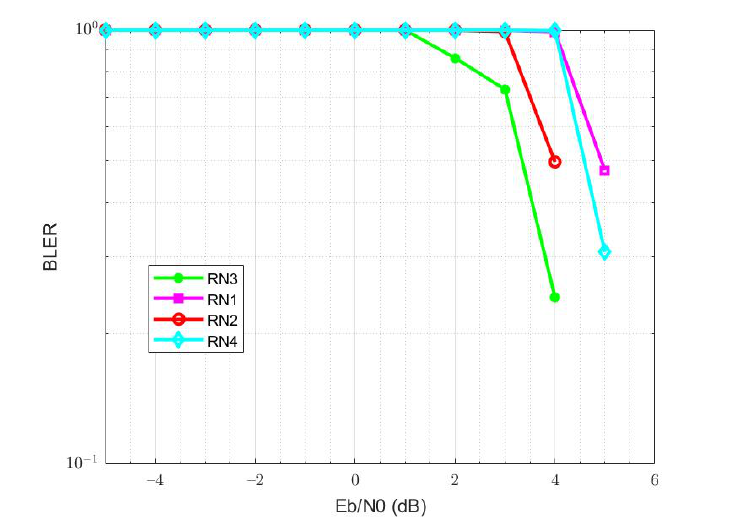
Figure 7. Throughput of four RNs.